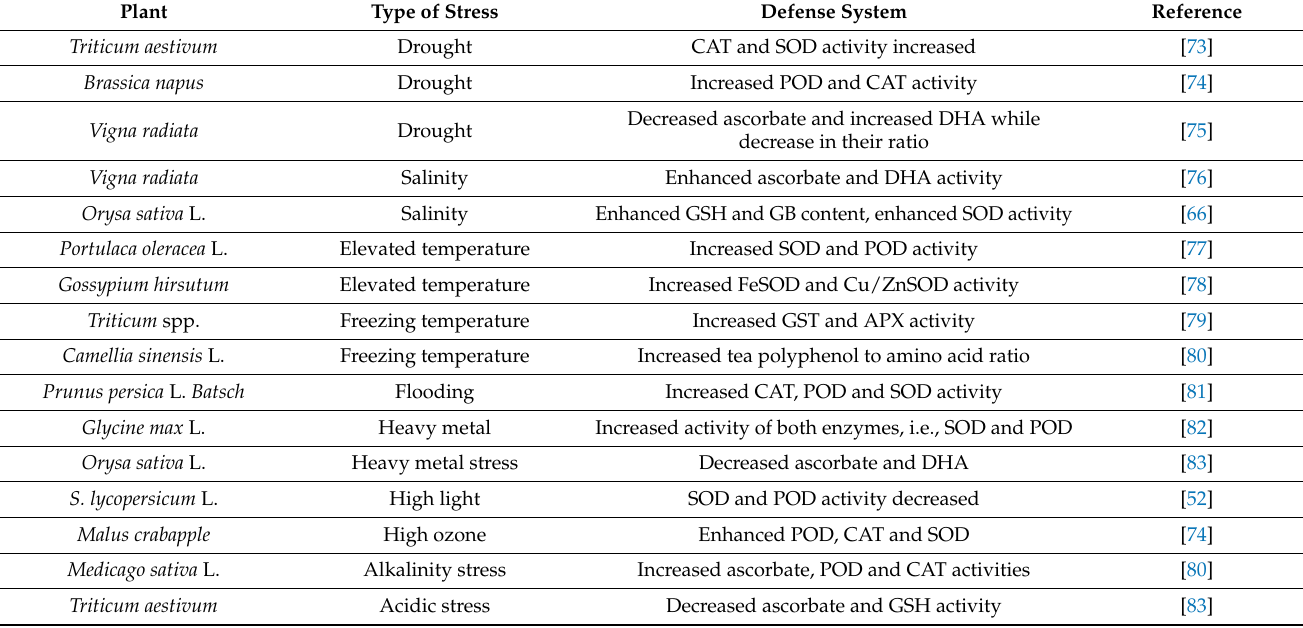
Table 1. Different types of plants and their associated stresses and defense